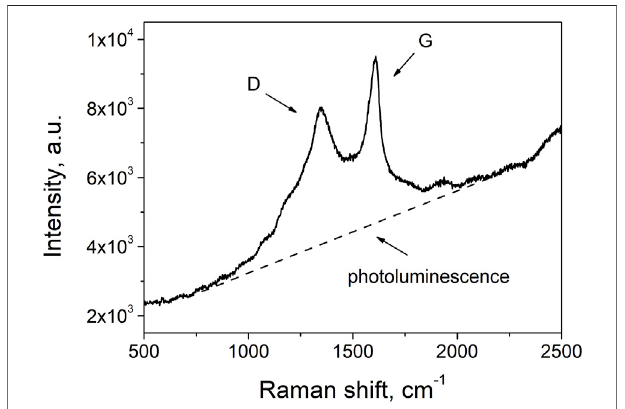
FIGURE 1 | First-order Raman spectrum of fl ame soot. Note: the spectrum refers to the Z8 sample at ambient temperature.